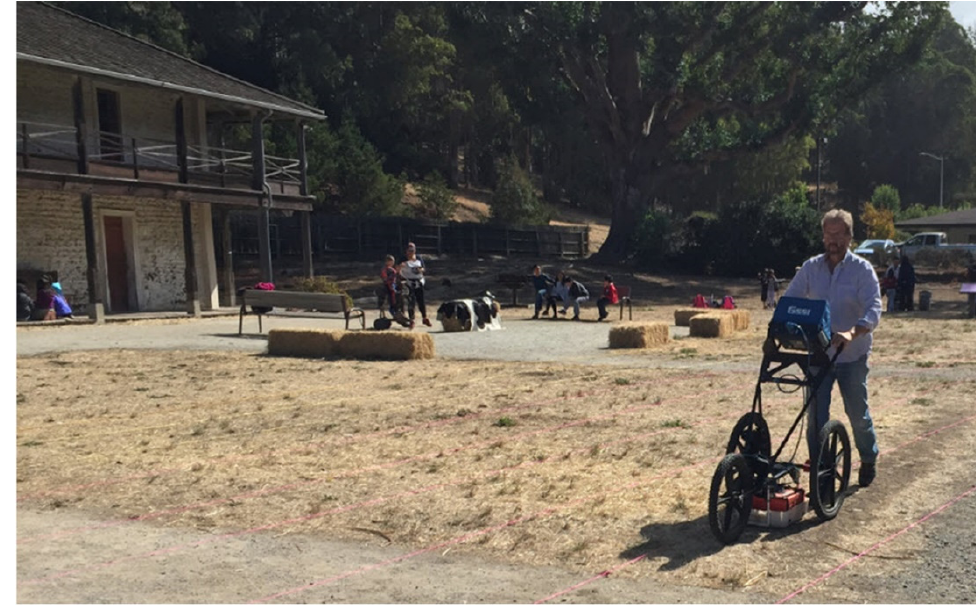
Figure 9. GPR survey of Sanchez Adobe plaza with 400 MHz antenna.